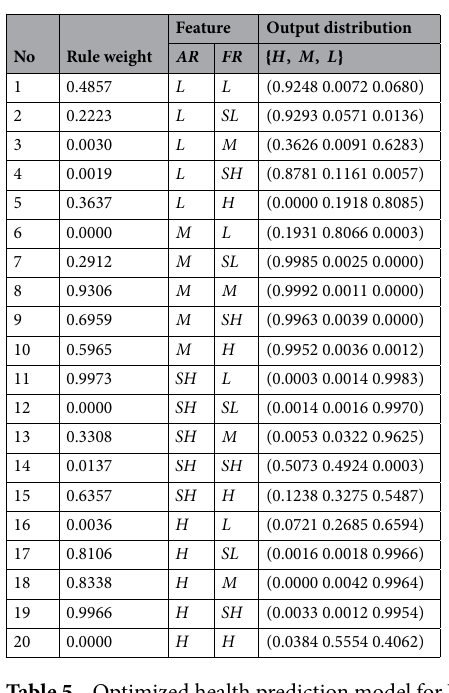
Table 5. Optimized health prediction model for WSN.